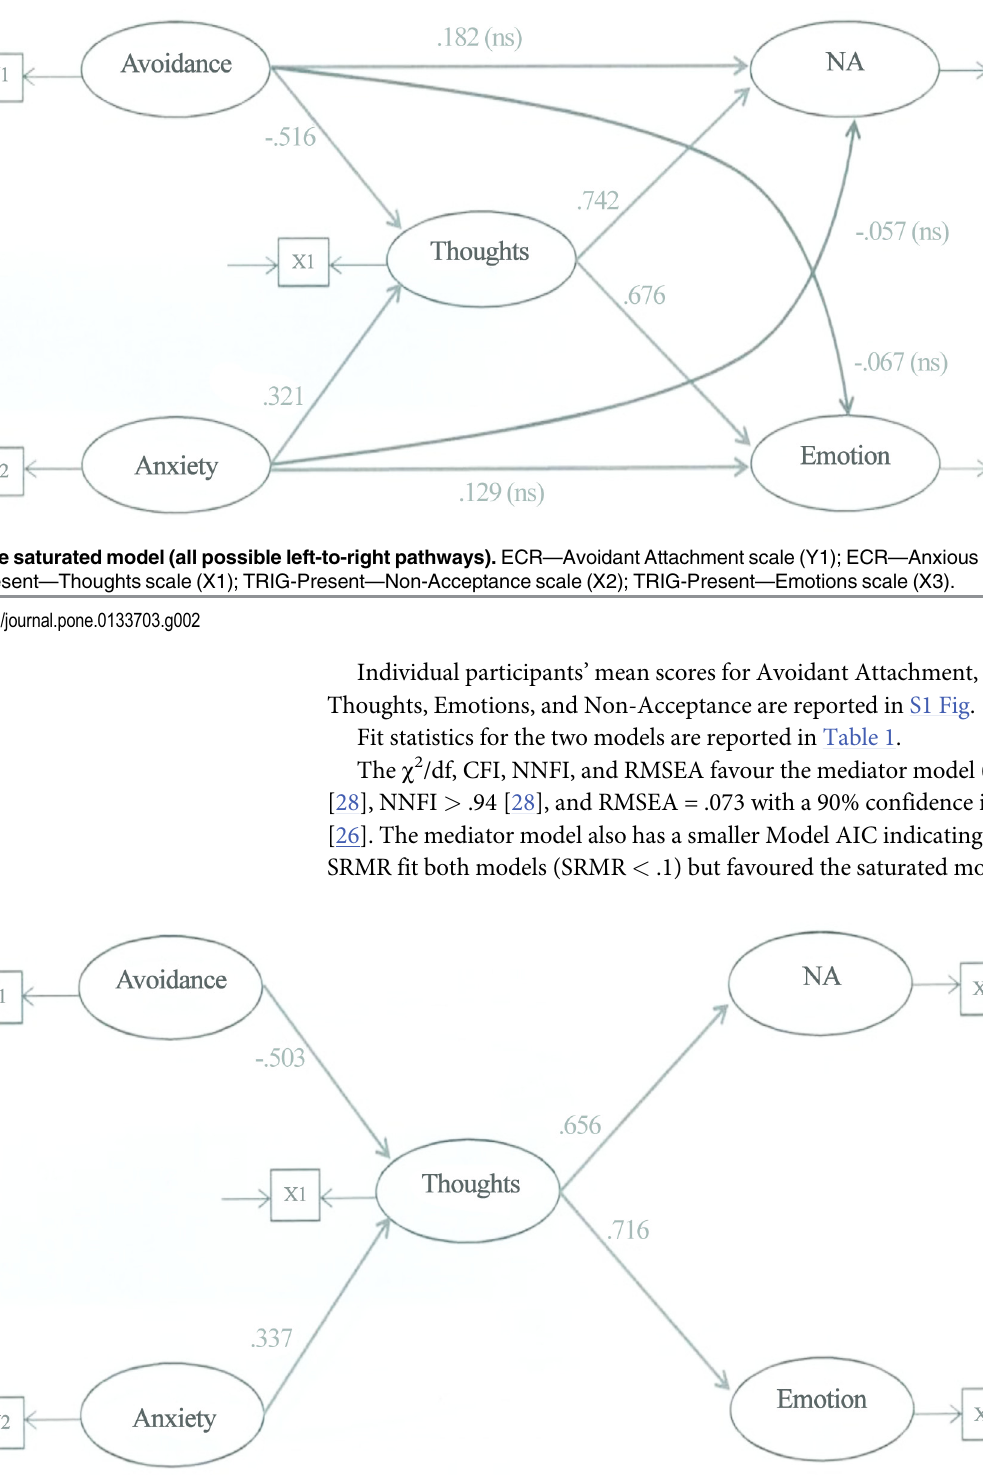
Fig 3. The mediator model (direct pathways were non-significant and therefore they were deleted from the model). ECR — Avoidant Attachment scale (Y1); ECR — Anxious Attachment scale (Y2); TRIG-Present — Thoughts scale (X1); TRIG-Present — Non-Acceptance scale (X2); TRIG-Present — Emotions scale